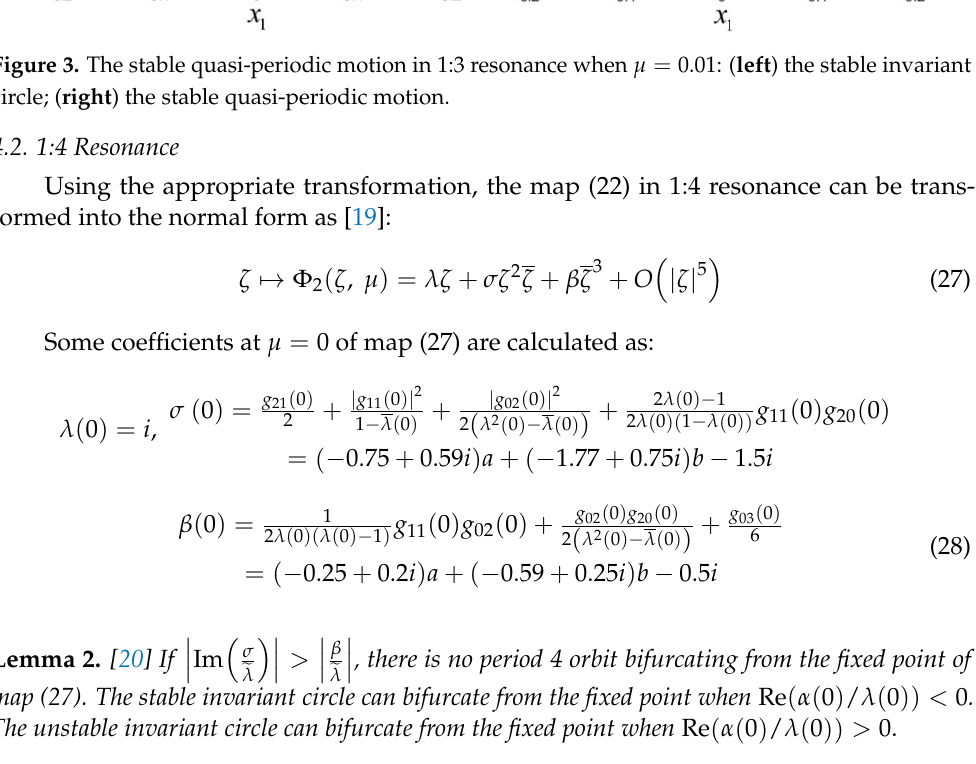
μ : ( left ) the stable invariant